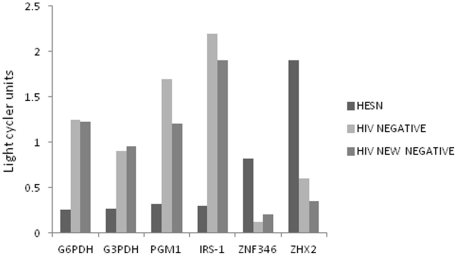
Outcome of a comparative quantitative RTPCR validation on randomly selected genes from the microarray analysis.Genes expression profiles from HESNs were compared with HIV uninfected non sex worker maternal child health clinic attendees (HIV negative) and HIV Negative new entrants into the sex trade (New Negatives). Each assay was a ratio gene quantity to its 18srRNA. G6PDH- glycose 6 phospate dehydrogenase; G3PDH-Glyceraldehyde 3 phosphate dehydrogenase; PGM-1-Phosphoglucomutase-1; IRS-1-Insulin receptor substrate-1; ZNF346-Zinc finger nuclease 346; ZHX2- Zinc finger and homeodomain protein 2.